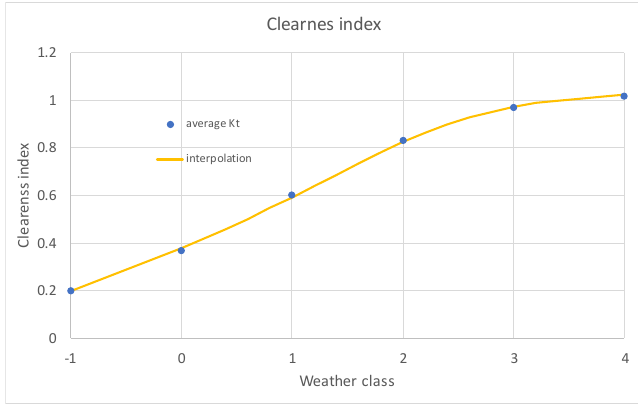
Figure 1. Polynomial interpolation of the clearness index over weather classes.